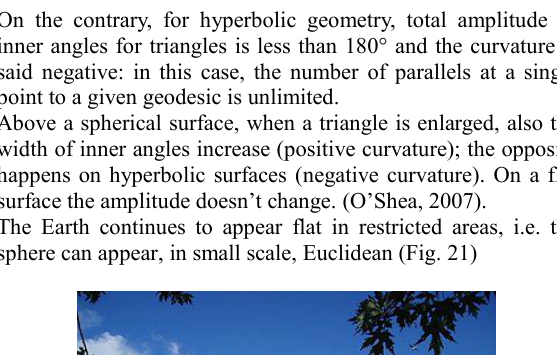
Fig.20 Le café de nuit (Van Gogh, 1888)